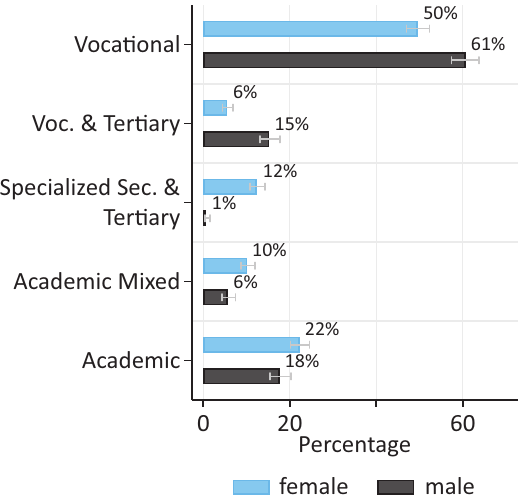
Figure 2. Distribution of men and women in the educa- tional clusters, grey spikes: